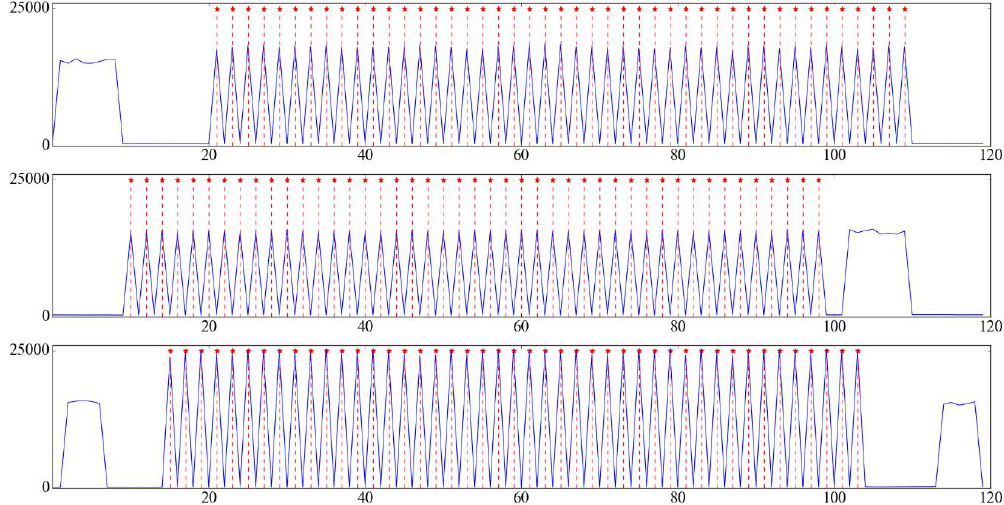
Figure 17. Sequence match result of Figure 14. Axis x denotes the frame index and axis y denotes the value of O . The red star symbols indicate the frames are flash